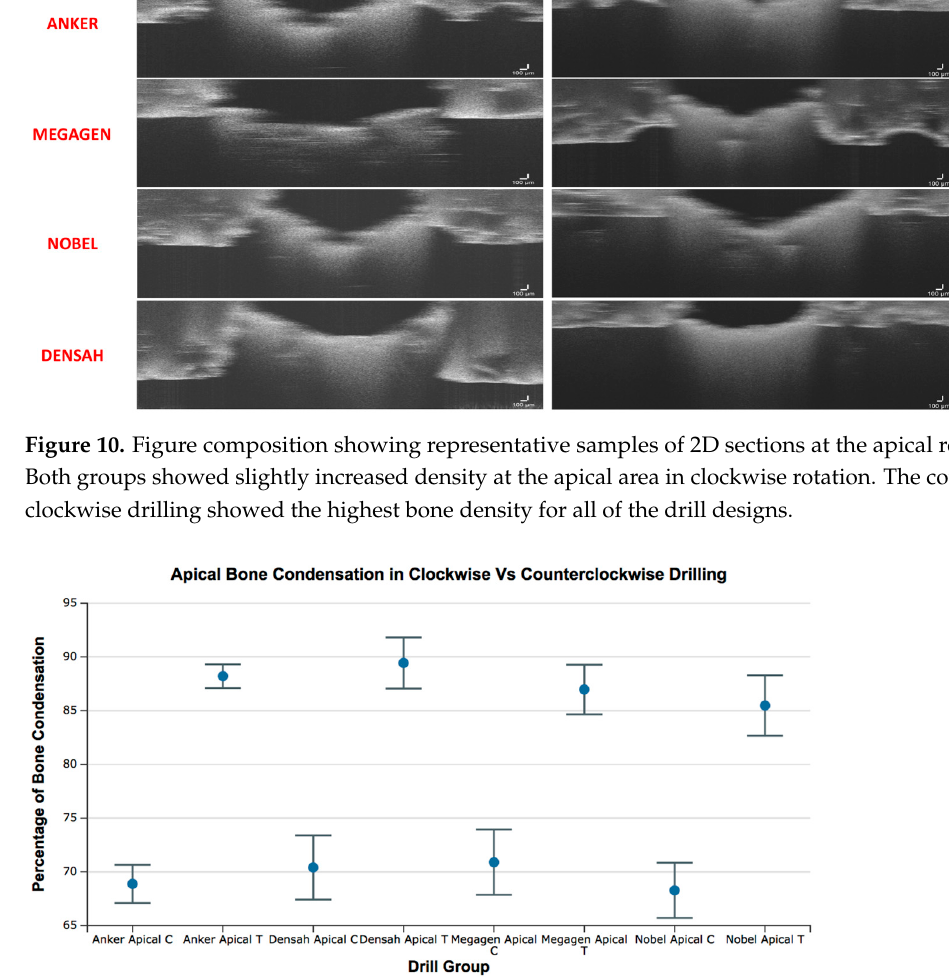
C = clockwise drilling; T = counterclockwise